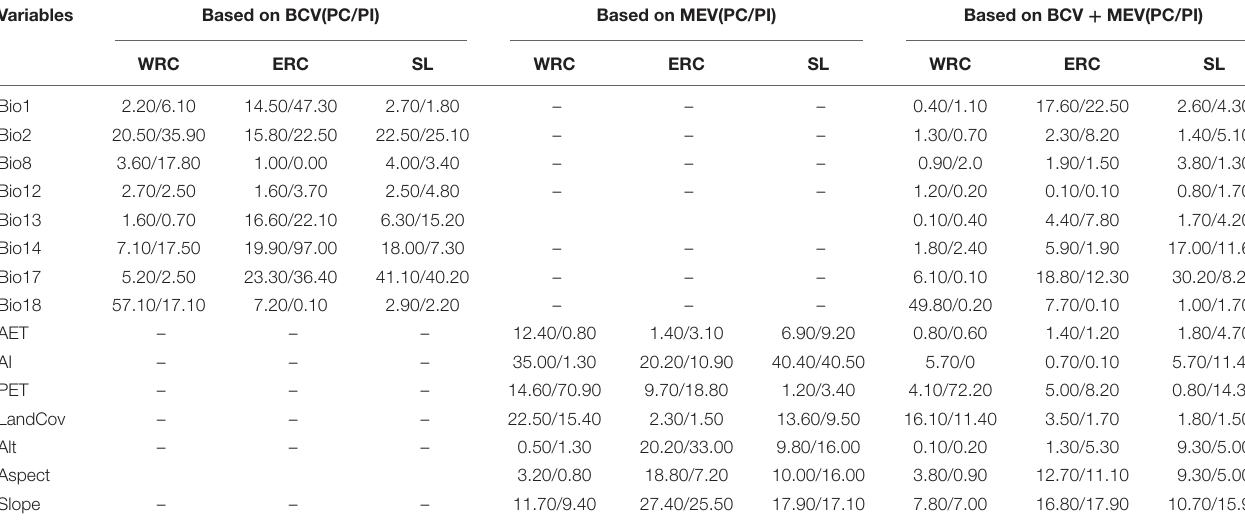
TABLE 1 | Percent contribution (PC) and permutation importance (PI) of eight bio-climatic (BCV) and seven macro-environmental (MEV) variables for the two western and eastern regional clades (WRC and ERC) and at species-level (SL). Variables Based on BCV(PC/PI) Based on MEV(PC/PI) Based on BCV +